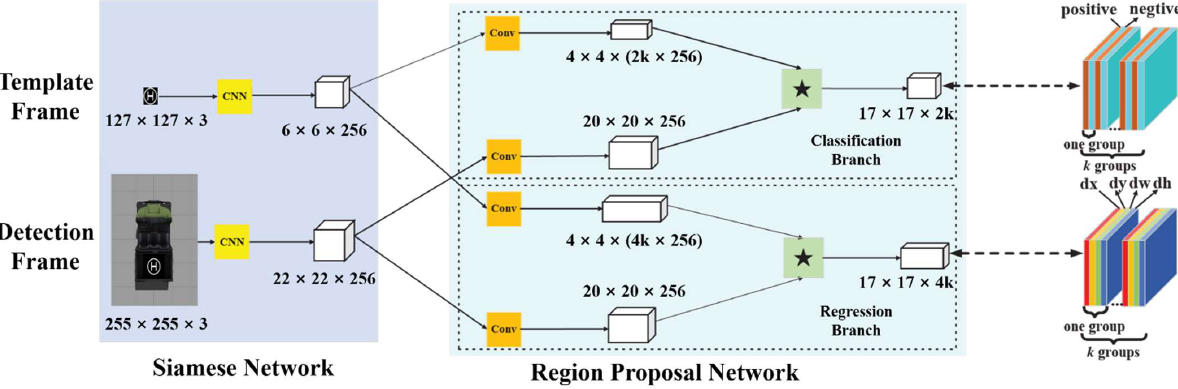
Figure 3. SiamRPN model structure. The star symbol represents Depthwise convolution.